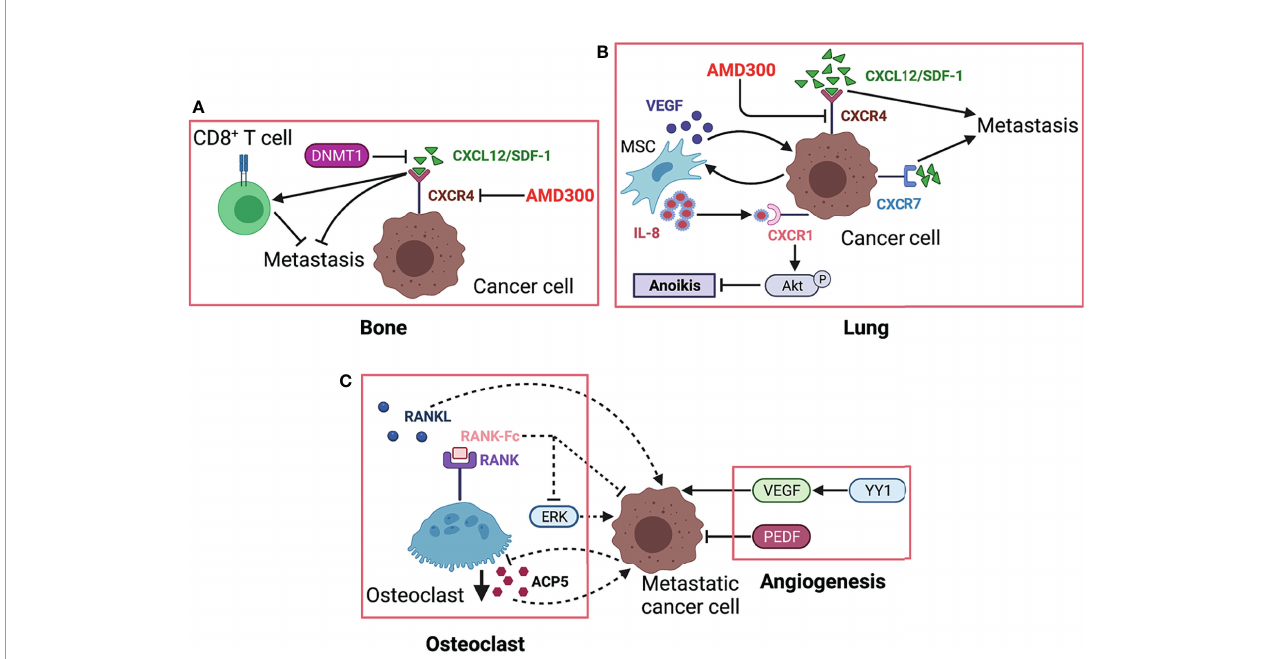
FIGURE 3 | The role of osteoclast and CXCR/CXCL axis in OS metastasis. (A) Highly expressed CXCL12. The CXCR4/CXCL12 (SDF-1) interaction is critical for OS metastasis in the lung, which is further strengthened by MSC via secreting VEGF. MSC-derived IL-8 induces OS cell anoikis resistance by activating CXCR1/Akt signaling. Another receptor CXCR7 expressed on OS cells promotes lung metastasis and enhances the malignancy activity of CXCR4. (B) RANK-Fc binds to RANK as a potent RANKL antagonist to inhibit osteoclast formation and activity, which can reduce OS metastasis, partly by suppressing ERK. Controversially, metastasis- competent OS cells induce loss of ACP5 + osteoclasts, which in turn enhances metastasis. Herein, we used dotted lines to indicate this contradiction. VEGF exhibits prometastatic effects on OS cells while PEDF shows the opposite by regulating angiogenesis. (C) In primary bone site, OS epigenetically downregulates CXCL12 expression by DNMT1, impairs cytotoxic T-cell homing to the tumor site, and this chemokine gradient of CXCL12 drives the metastasis of OS cells to the lung. ACP5/TRAP, osteoclast-speci fi c tartrate-resistant acid phosphatase 5; PEDF, pigment epithelium-derived factor; YY1, Yin Yang 1 protein; CXCL12, C – X – C motif chemokine 12; DNMT1, DNA methyltransferase 1; CXCR4, chemokine receptor 4; AMD3100, CXCR4